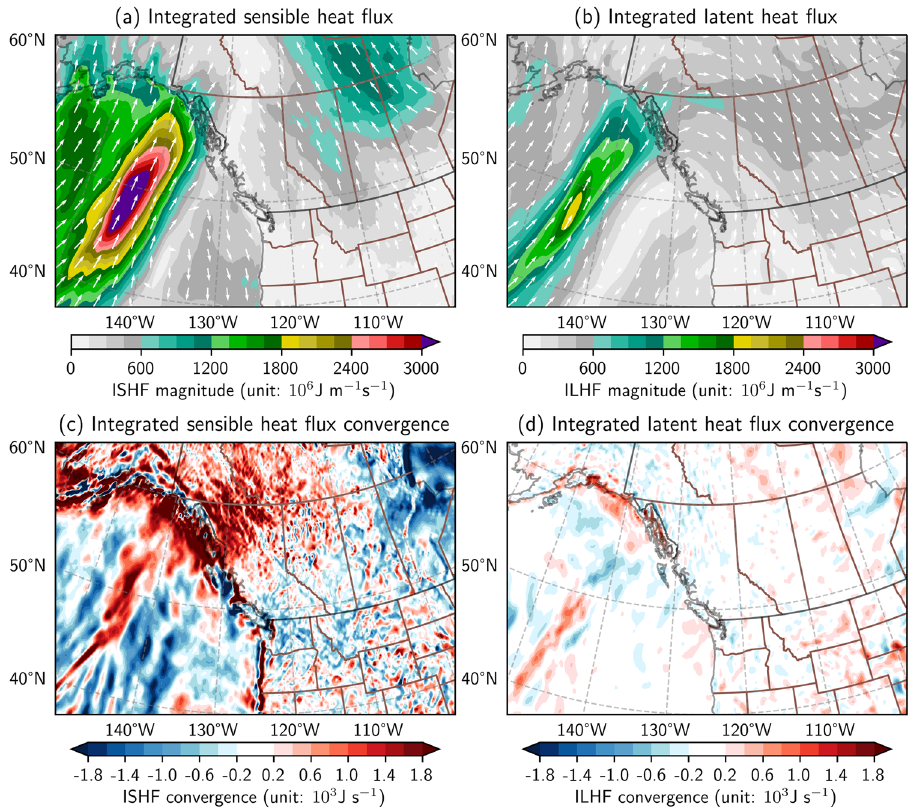
Fig. 6 Sensible and latent heat transport in the lower troposphere averaged over 24 – 27 June 2021. a The integrated sensible heat fl ux (ISHF). b The integrated latent heat fl ux (ILHF). c The ISHF convergence. d The ILHF